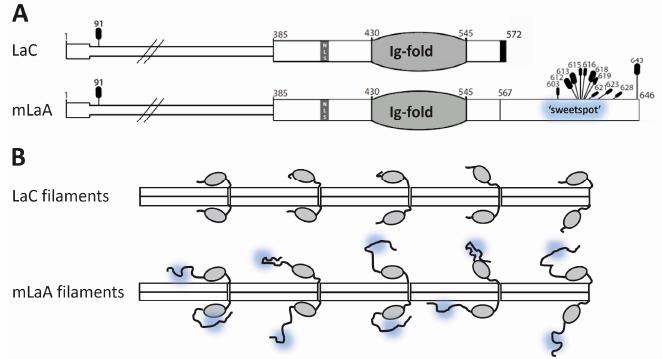
Figure 7. Schematic of mature lamin A and lamin C proteins, and filaments. ( A ) Schematic of the lamin A and lamin C proteins, which have identical residues 1–566, showing all currently identified O -GlcNAc sites. The Ig-fold is shaded gray; black indicates the short C-terminal region unique to lamin C. Long vs. short black ovals indicate greater or lesser abundance at each identified O -GlcNAc site, determined here for the lamin A tail (see text). The O -GlcNAc-modified region (‘sweetspot’) is highlighted in yellow, for comparison to panel B. Whether the O -GlcNAc site at T91 identified in embryonic stem cells [48] is present on both lamins (as depicted here), or limited to one type, is unknown; ( B ) molecular impact on filaments formed by lamin A versus lamin C. Competing or synergistic O -GlcNAc and phosphate modifications are predicted to drive different conformations of the lamin A tail, some of which may sterically block access to the Ig-fold domain (gray).